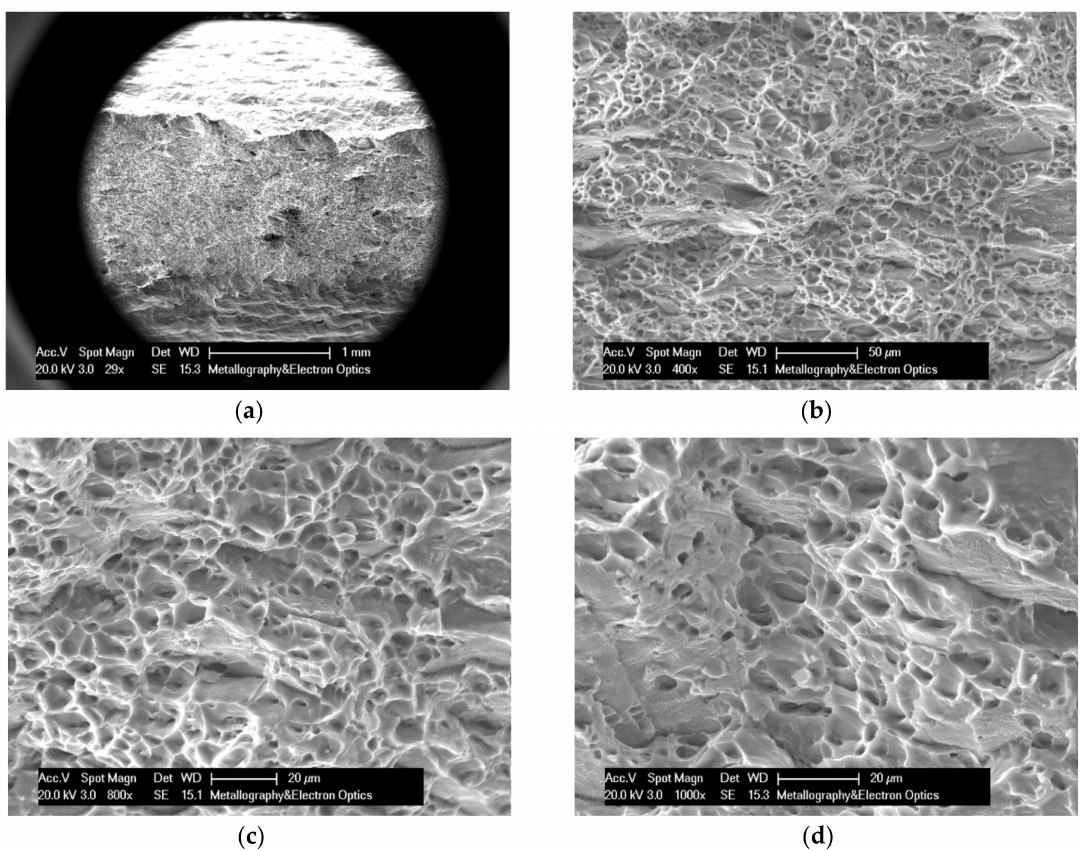
Figure 7. ( a – d ) SEM fractographs, fracture surface of tensile specimen with 3.2 mm thickness. Mostly dimpled ductile fracture is